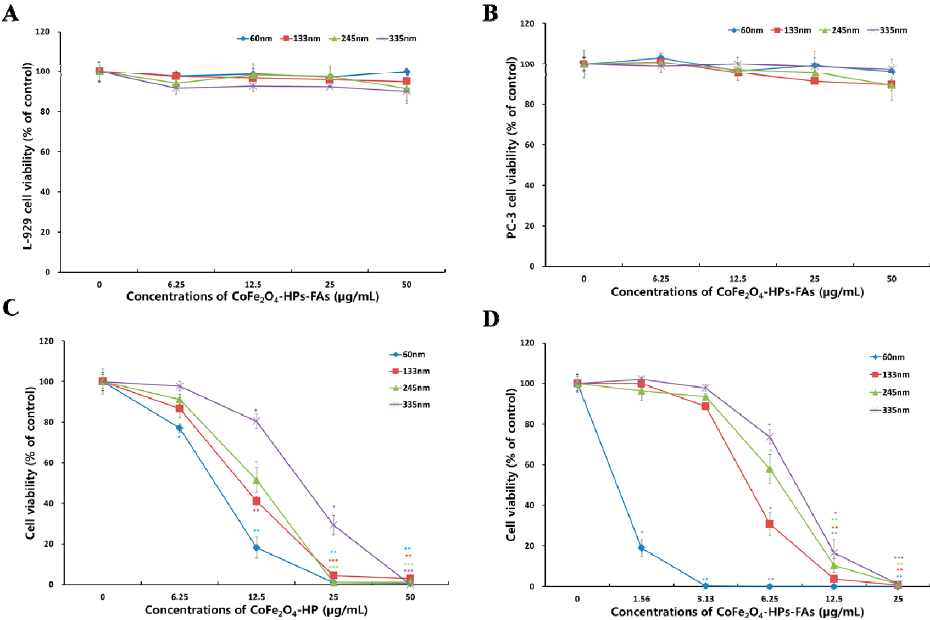
Figure 3. Cytotoxicity and photodynamic anticancer activity of multifunctional magnetic particles in PC-3 cells. ( A ) Cytotoxicity in fibroblast (L-929 cells) and ( B ) prostate cancer (PC-3 cell). Cells were cultured with different concentrations of CoFe 2 O 4 -HP-FA for 24 h at 37 °C in the dark; ( C ) Photodynamic anticancer activity of each size of CoFe 2 O 4 -HP in PC-3 cells; ( D ) Photodynamic anticancer activity of each size of CoFe 2 O 4 -HP-FA in PC-3 cells. Cells were incubated with different concentrations of CoFe 2 O 4 -HP and CoFe 2 O 4 -HP-FA for 2 h in the dark prior to irradiation for 30 min. Data are expressed as the mean ± standard deviation ( n = 6) and were analyzed by Student’s t -test. Statistical significance was defined as p < 0.05 (* p < 0.05, ** p < 0.005, *** p < 0.001 vs. control at the same time).